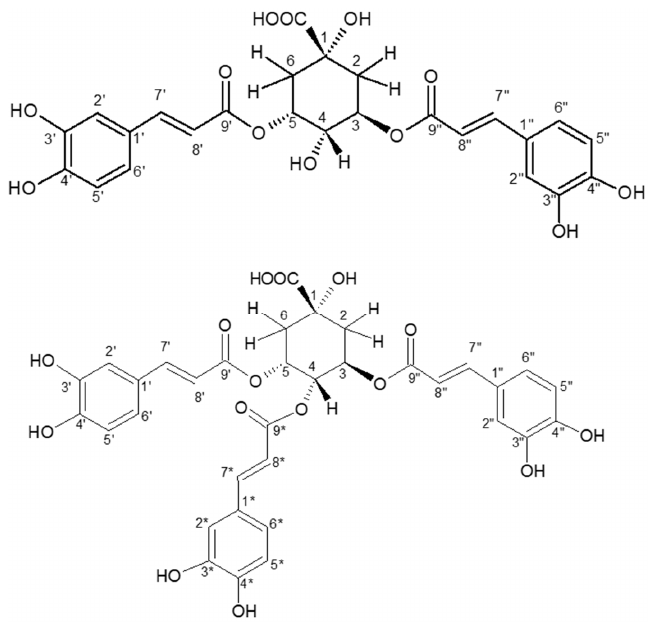
Figure 7. Chemical structures of 3,5-dicaffeoylquinic acid (di-CQA) and 3,4,5-tricaffeoylquinic acid (tri-CQA).